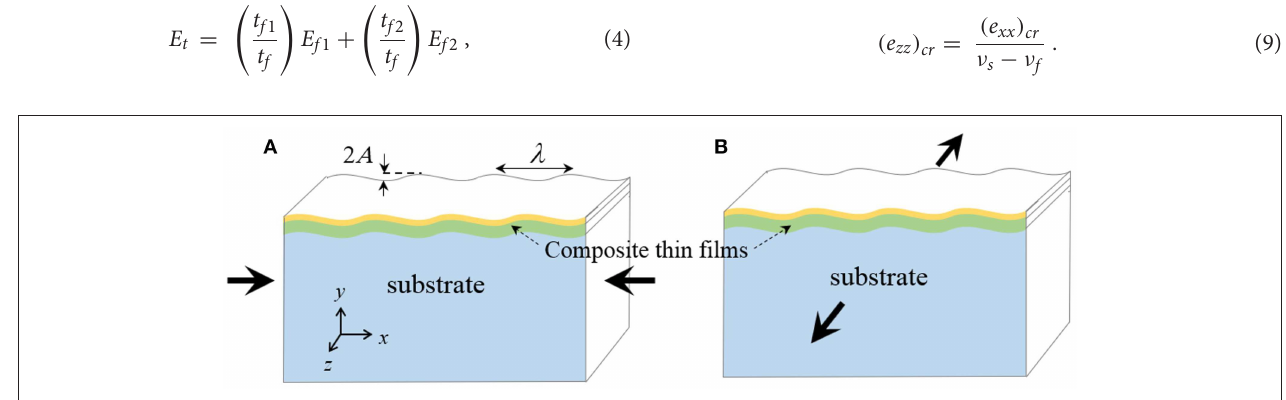
FIGURE 1 | Schematics showing the formation of buckles (wrinkles) during (A) compression along the x -direction and (B) applied tension along the z -direction. The scenarios in (A,B) are also termed direct compression and indirect compression, respectively.